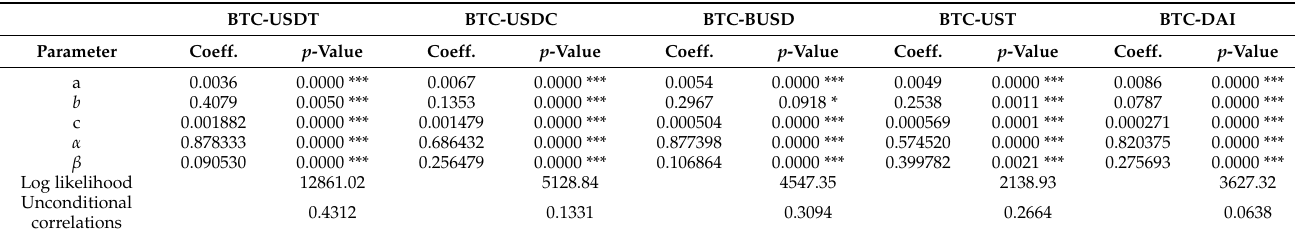
Table 4. The results of the Copula -DCC-GARCH model parameter estimates.